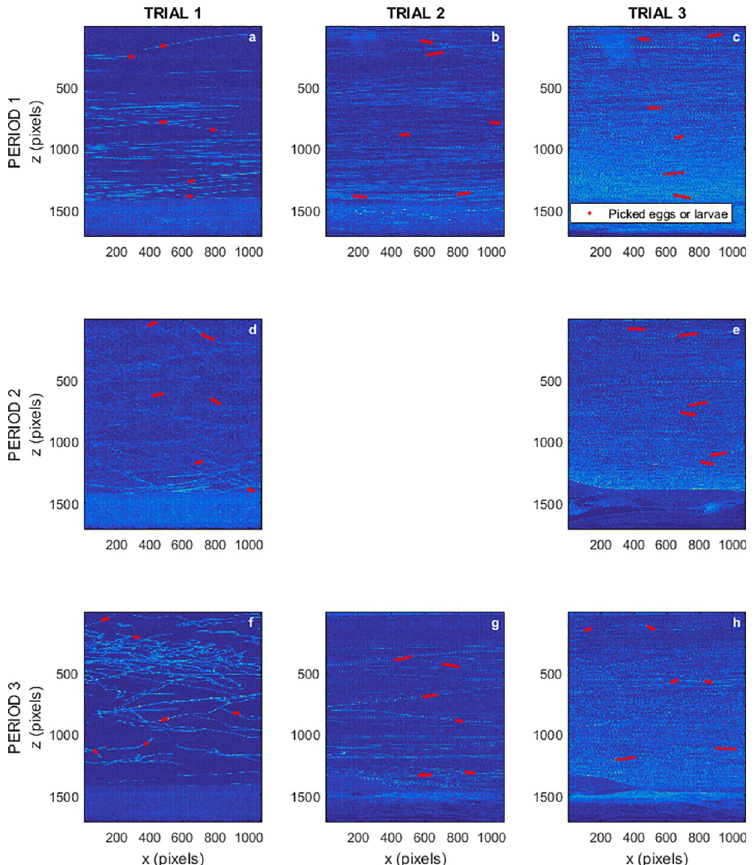
Fig 6. Composite images showing eggs and larvae trajectories at every developmental period and flow speed. (a,d, f) Trial 1. (b,g) Trial 2. (c,e,h) Trial 3. For developmental periods: Period 1 (a-c), Period 2 (d-e), and Period 3 (f-h). Red trajectories shown as examples of those used to estimate traveling and swimming